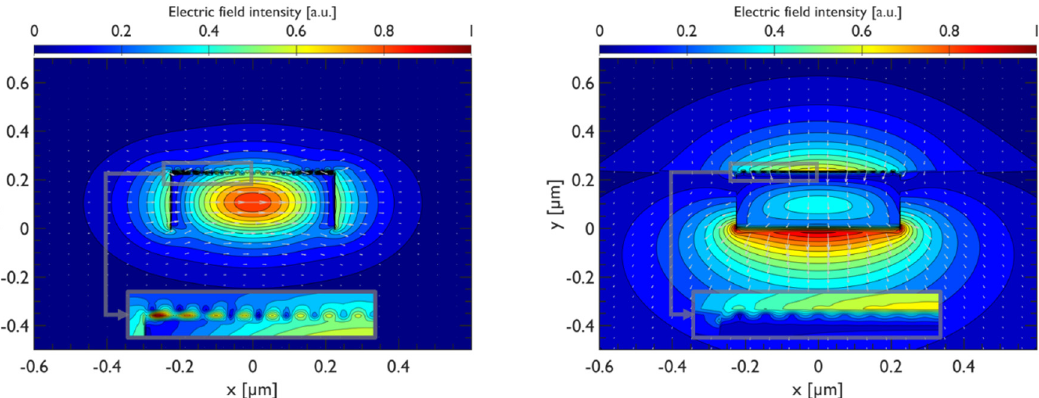
Figure 5. TE ( left panel ) and TM ( right panel ) modes of the SOI waveguides coupled to graphene nanoribbons ( µ c = 1.6 eV). nanoribbons ( µ c = 1.6